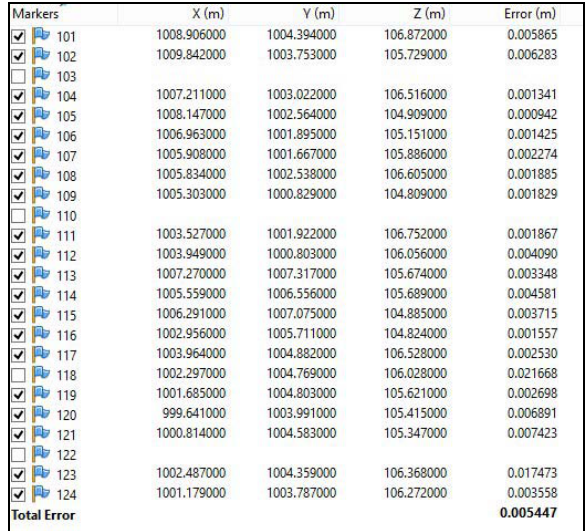
Figure 18 – View of GRP’s / GCP’s on the Photogrammetric Dense Point Cloud.